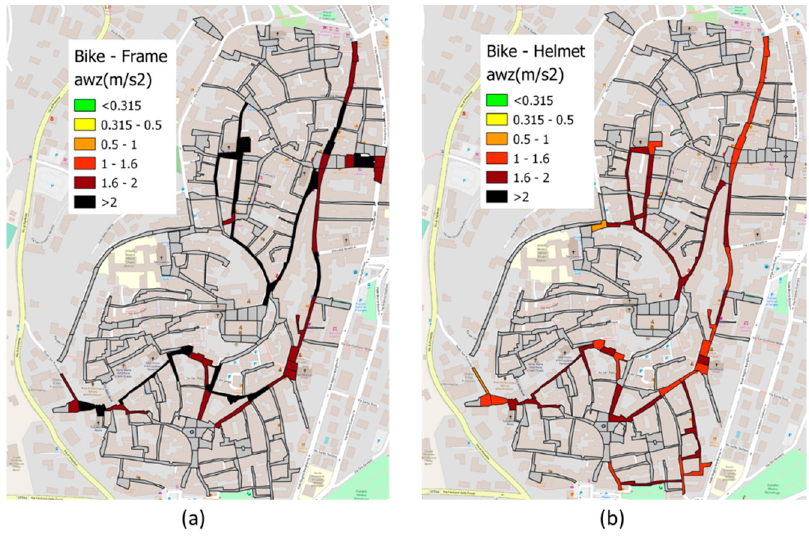
Figure 17. a wz bike results: ( a ) bike frame results ( b ) bike helmet results.